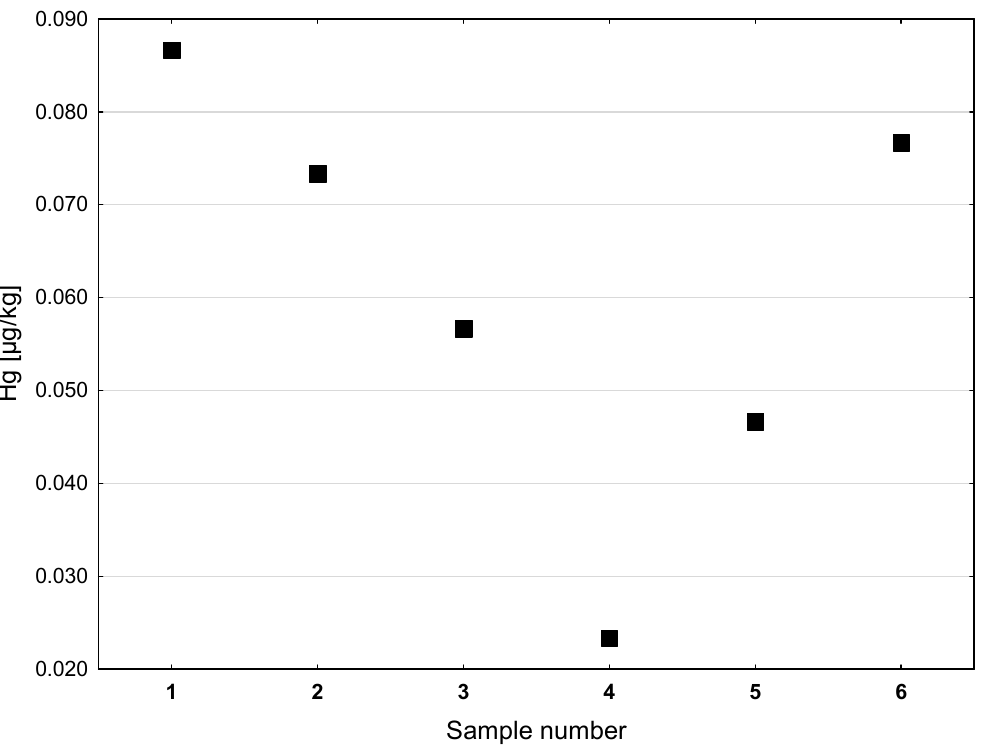
Figure 2. Hg concentrations in vegetable oils, cod liver oils, and shark liver oils ( µ g/kg).